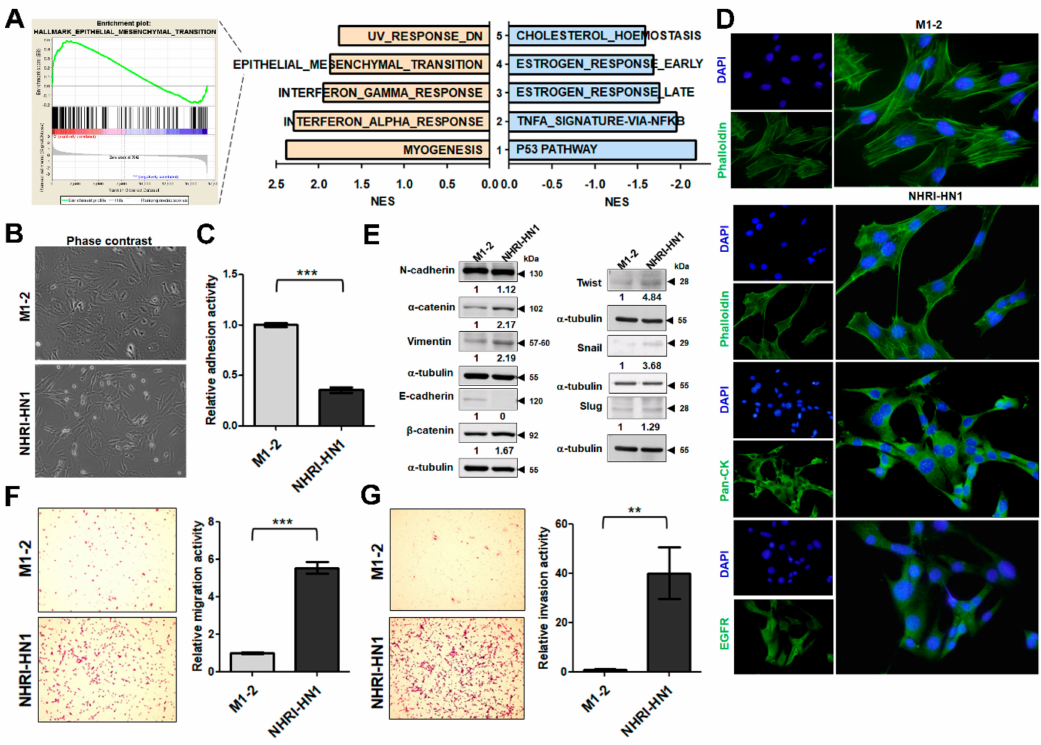
Figure 4. Detection of EMT and increased motility in NHRI-HN1 cells. ( A ) Summary of the most enriched pathways associated with tumorigenesis in syngeneic mice by comparing tumorigenic NHRI-HN1 cells with nontumorigenic cells, including M1-2, M2-3 and NHRI-HN2, using GSEA analysis. Blue indicates a negative normalized enrichment score (NES) and orange indicates a positive NES. ( B ) Morphology of M1-2 and NHRI-HN1 cells via phase-contrast microscopy at 100 × magnification. ( C ) Relative adhesion activity in M1-2 and NHRI-HN1 cells, determined by normalizing the mean OD 490 nm value of NHRI-HN1 cells to that of M1-2 cells. ( D ) Cells stained with Alexa Fluor 488 phalloidin, anti-pan-CK and anti-EGFR antibodies at 400 × magnification. ( E ) Immunoblot analysis of epithelial (E-cadherin, α -catenin and β -catenin), mesenchymal (N-cadherin and Vimentin) proteins and EMT-related transcription factors, including Twist, Snail and Slug in M1-2 and NHRI-HN1 cells. Protein levels were normalized to an internal control, α -tubulin. Ratios were determined by dividing the normalized protein levels in NHRI-HN1 cells by that in M1-2 cells. ( F ) Representative images (left) and relative data (right) for migration activity of M1-2 and NHRI-HN1 cells. ( G ) Representative images (left) and relative data (right) for invasion activity of M1-2 and NHRI-HN1 cells at 200 × magnification. The relative migration or invasion activity was determined by normalizing the mean number of cells that have migrated or invaded per field of NHRI-HN1 cells to that of M1-2 cells. Error bars represent SE; ** p < 0.01; *** p <